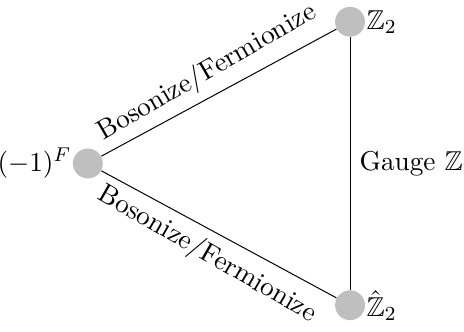
Figure 10 . Gauging the ( − 1) F symmetry of a spin theory T f produces a bosonic theory with a Z symmetry. A different bosonic theory can be produced if one first stacks with the invertible 2 Arf theory. These two phases are related by Z to